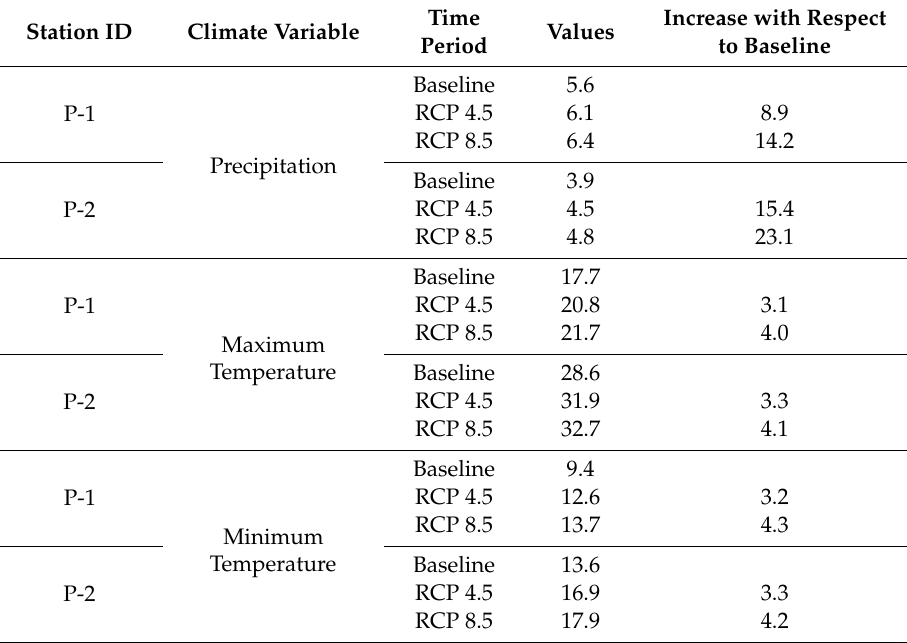
Table 2. Comparison of climate variables at station P-1 and P-2 under RCP 4.5 and RCP 8.5.